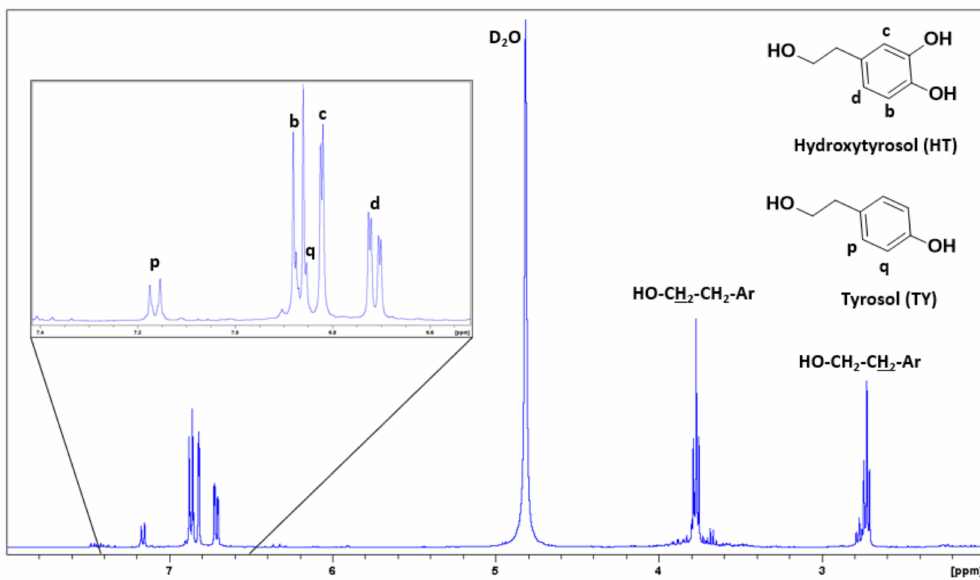
Figure 5. 1 H-NMR spectrum (500 MHz, D 2 O) from S1 organic phase after ethyl acetate extraction of table olive processing wastewater